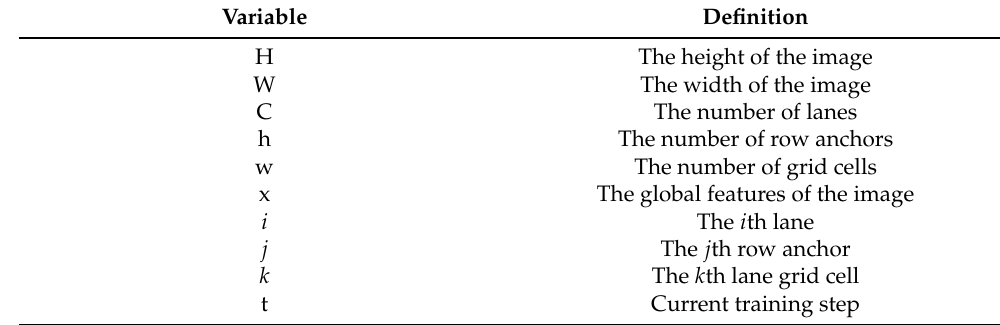
Table 5. Preliminary notations.